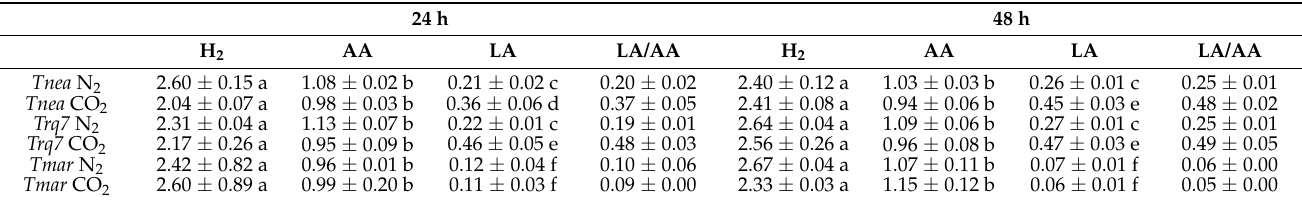
Table 1. Hydrogen, acetic acid (AA), and lactic acid (LA) yields (mol/mol glucose) at 24 and 48 h. Letters indicate ANOVA significant differences between treatments, chemical products and bacterial species. Data are expressed as mean ± SD, n = 9.